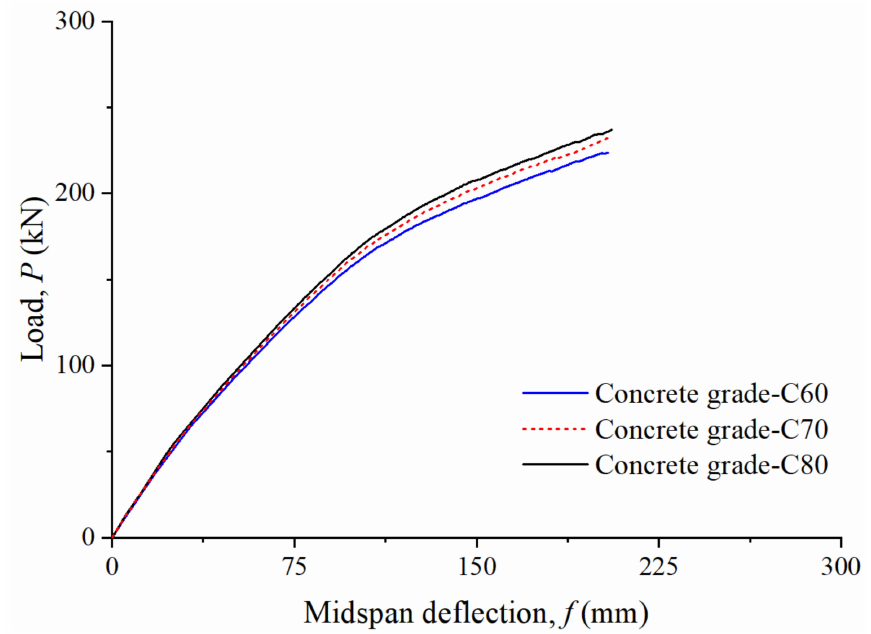
Figure 13. Influence of strength of concrete on the bending strength of